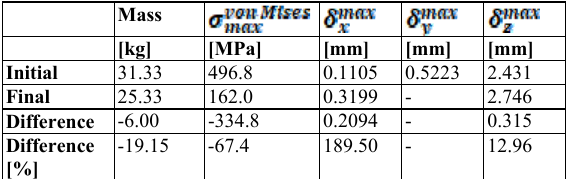
Figure 16. Equivalent von Mises stresses in the structure 3rd FEM analysis Table 3. Comparison between the initial and final design solutions and respective differences in mass, maximum von Mises stresses and displacements.